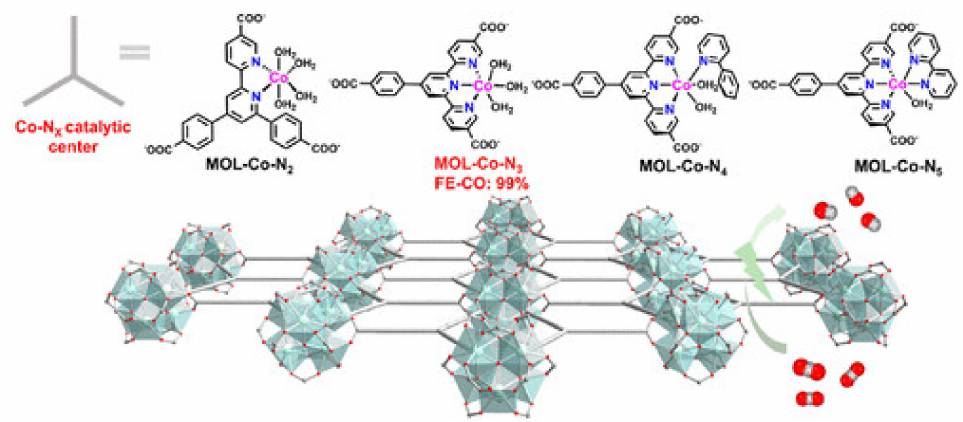
Figure 7. Schematic representation of structure of Co-N x (x = 2 − 5) centers in the MOLs. Reproduced from [48], with permission from American Chemical Society,